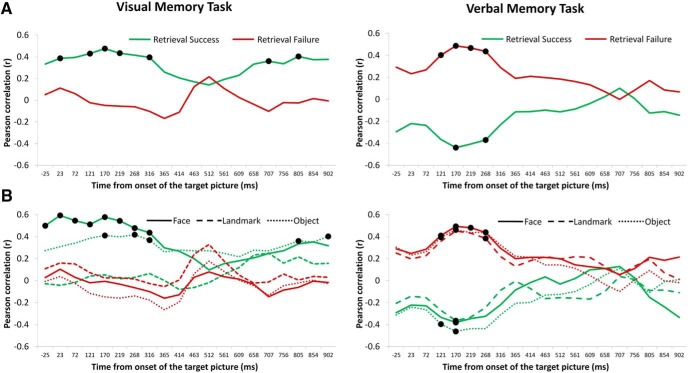
Pearson r values showing the temporal profile of the association between visual processing (tracked by EEG-based decoding) and memory performance in the visual and verbal memory task. Highlighted (•) are time bins for which the relationship with behavioral performance survived correction for multiple comparisons (for details, see Materials and Methods). A, The green line shows the association for retrieval success (i.e., exemplar hits) and the red line shows the association for retrieval failure (i.e., when participants fail to retrieve any information about the target picture). B, Association for retrieval success (green lines) separated for faces (solid green line), landmarks (dashed green line) and objects (dotted green line), and for retrieval failure (red lines) separated for faces (solid red line), landmarks (dashed red line), and objects (dotted red line).